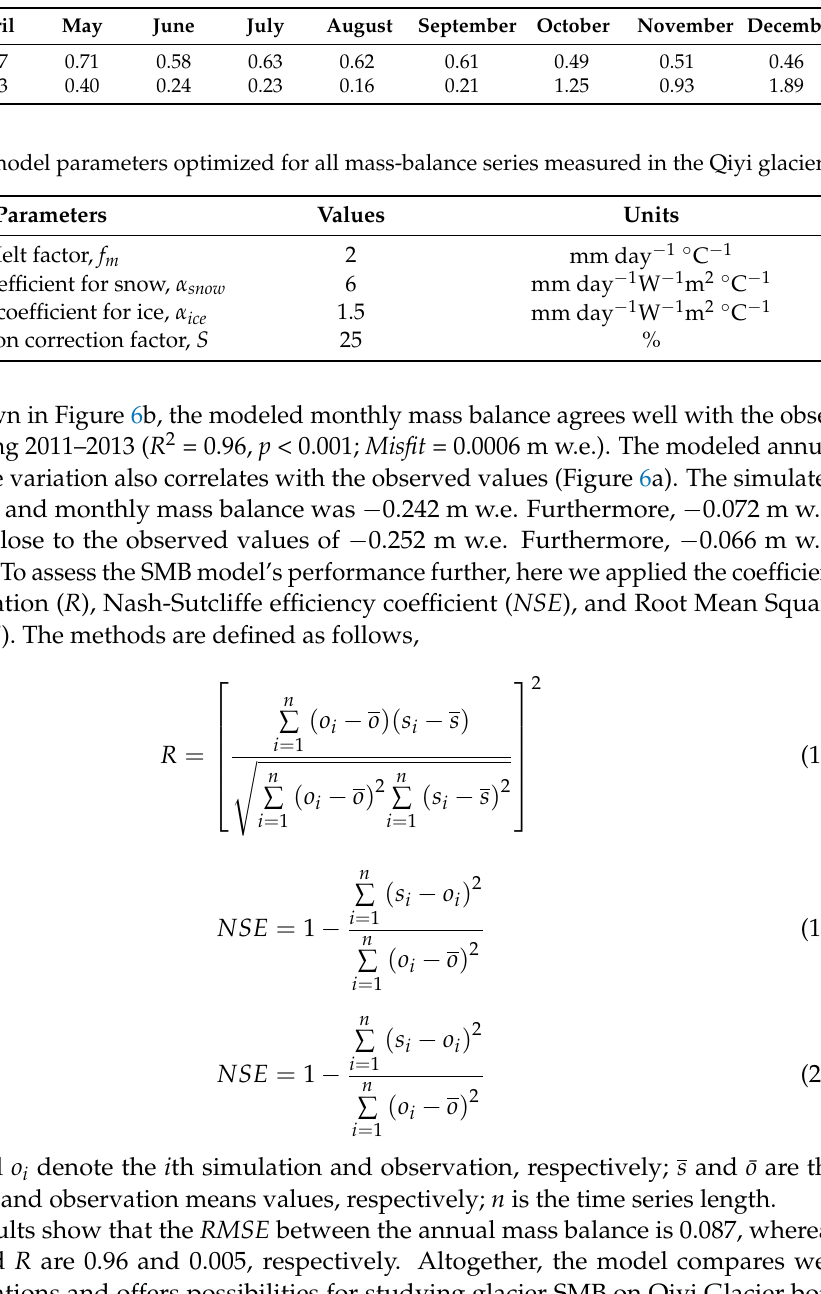
Table 4. The lapse rate of temperature ( λ T , ◦ C/100 m) and precipitation ( λ P , mm/d 100 m) of different months at the Qiyi glacier.